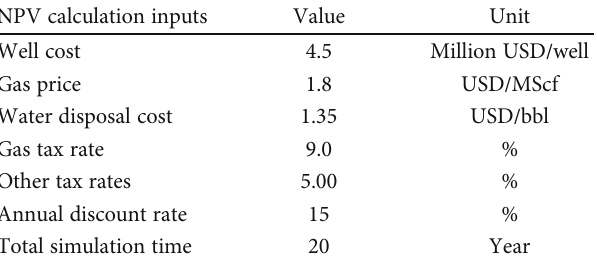
Table 4: Summary of economic input variables used in this study.